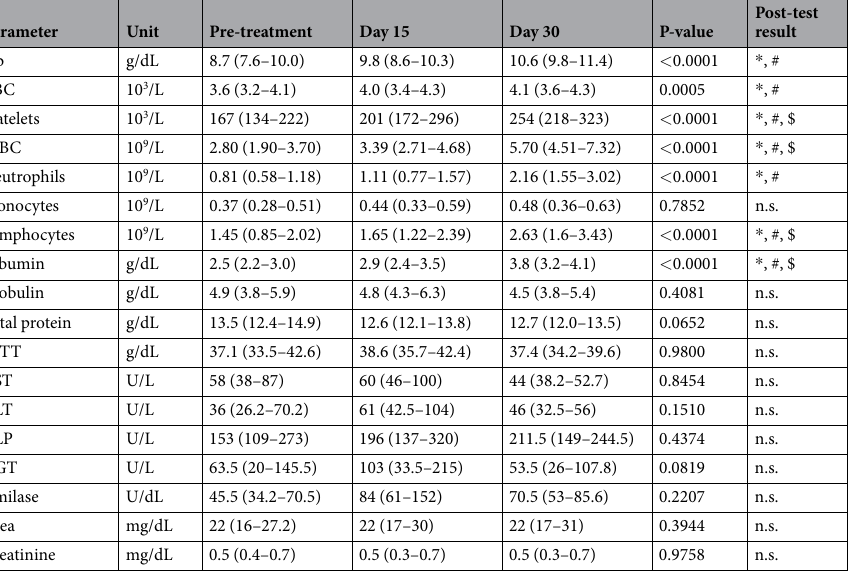
Table 3. Hematological and biochemical parameters from patients with visceral leishmaniasis before and after leishmanicidal treatment initiation. Values represent median and interquartile ranges. Log 10 transformed data (which presented Gaussian distribution) were analyzed using one-way ANOVA with Tukey’s multiple comparisons post-test. Column with P-values represent the one-way ANOVA comparisons. Column with P-values represent the one-way ANOVA comparisons. P-values from post-test are represented by the following: * p < 0.05 in Pre-treatment vs. Day 15; # p < 0.05 in Pre-treatment vs. Day 30; $ p < 0.05 in Day 1`s. Day